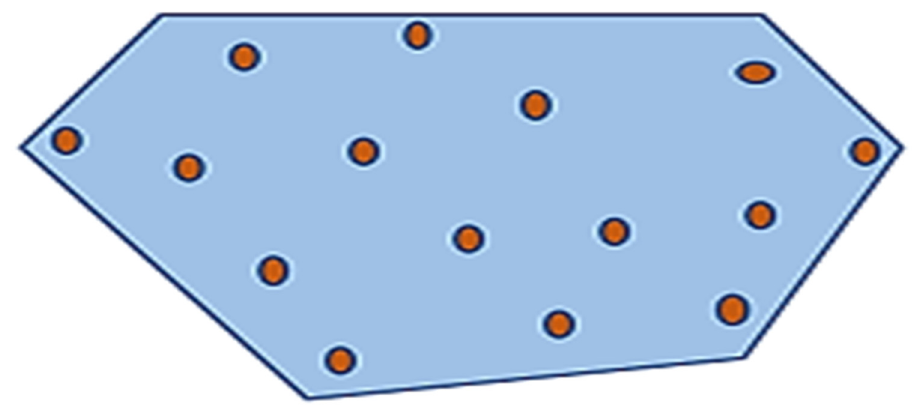
Figure 19. A 2D Convex Hull.